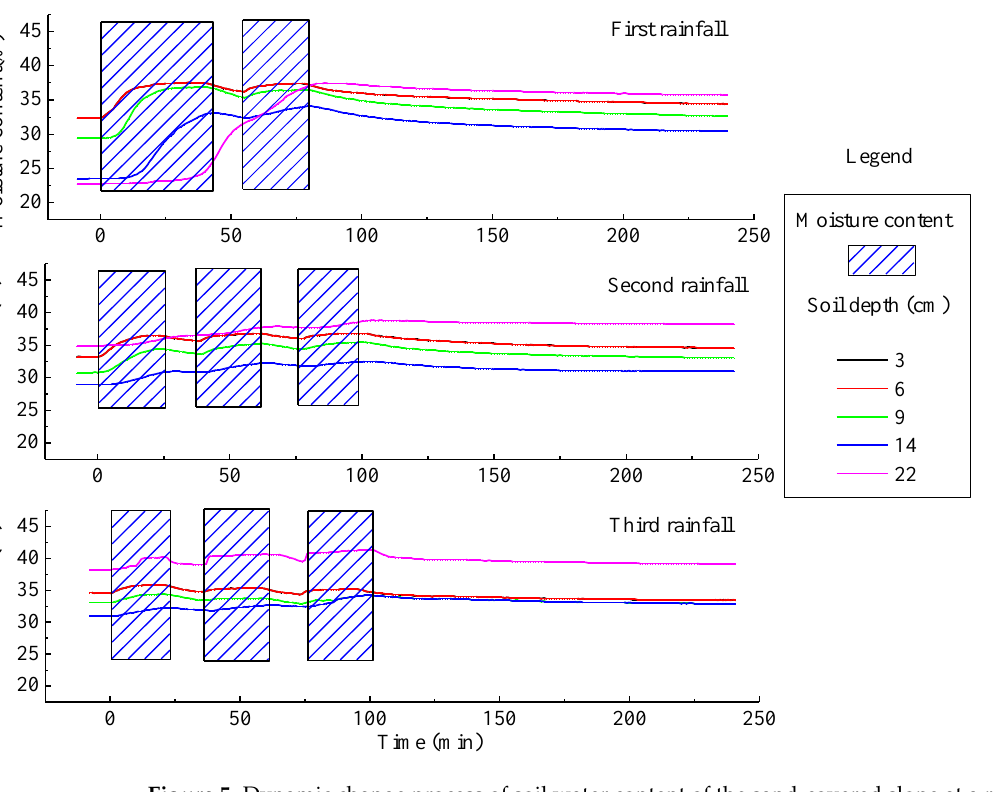
Figure 5. Dynamic change process of soil water content of the sand-covered slope at a rainfall density of 1.0 mm/min.